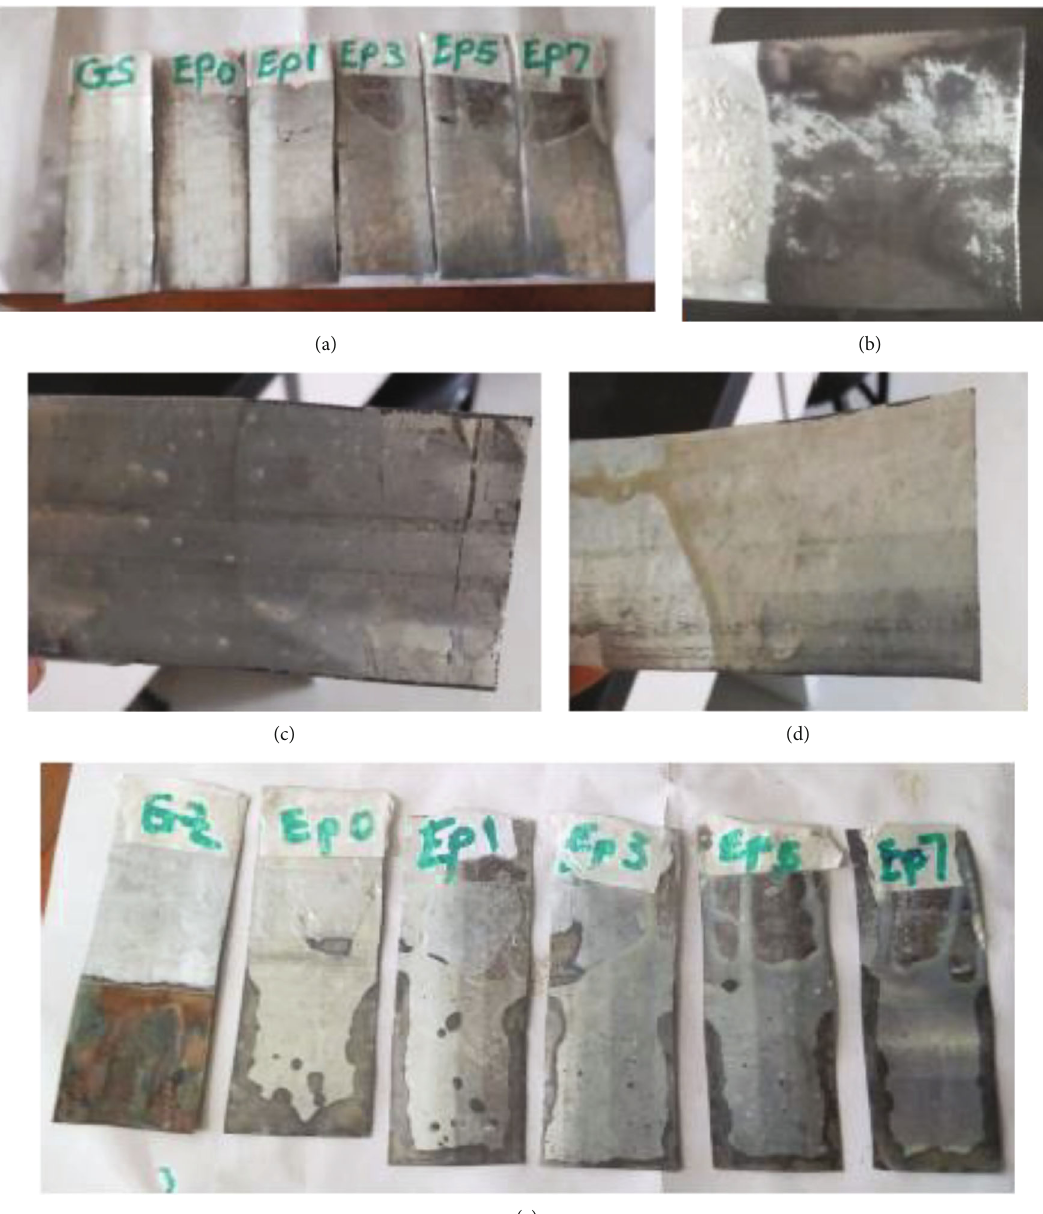
Figure 9: The e ff ect of strong acid on galvanized steel (a) before immersion, (b – d) GZ, EP5, and EP7, respectively, after 2 h immersions, and (e) after 24 h immersions in 2wt.% H